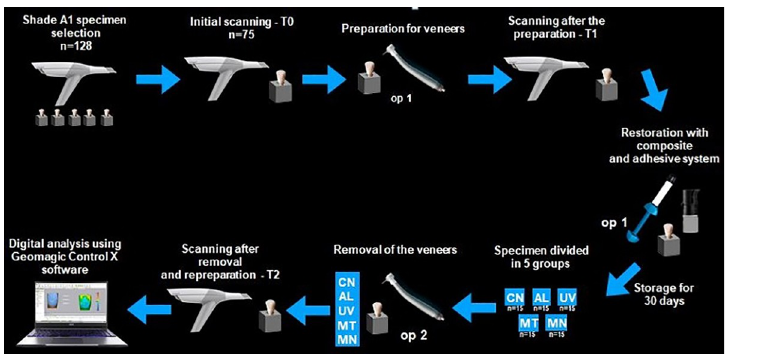
Fig 3. Flowchart of the